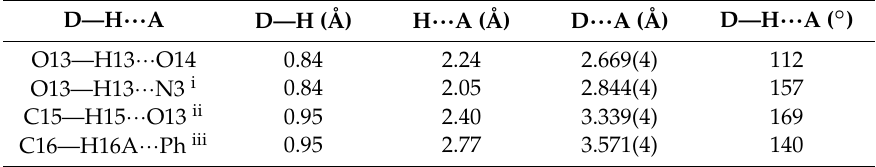
Figure 3. Geometry and three-dimensional arrangement of 2-(4-hydroxy-3-methoxyphenyl)-benzothiazole. Figure 2. Geometry and three-dimensional arrangement of 2-(4-hydroxy-3-methoxyphenyl)- ( A ) Intra and intermolecular hydrogen bonding scheme of the title compound. Intramolecular S ( 5 ) benzothiazole. ( A ) Intra and intermolecular hydrogen bonding scheme of the title compound. and intermolecular R 2 2 ( 7 ) motifs are observed; ( B ) helix formed by through O13—H13 ··· N3 hydrogen Intramolecular S(5) and intermolecular R 22 (7) motifs are observed; ( B ) helix formed by through bonding in the (14 -1 -3) plane. O13—H13∙∙∙N3 hydrogen bonding in the (14 -1 -3) plane. Table 2. Hydrogen bonding geometric features of Table 2. Hydrogen bonding geometric features of 2-(4-hydroxy-3-methoxyphenyl)-benzothiazole.